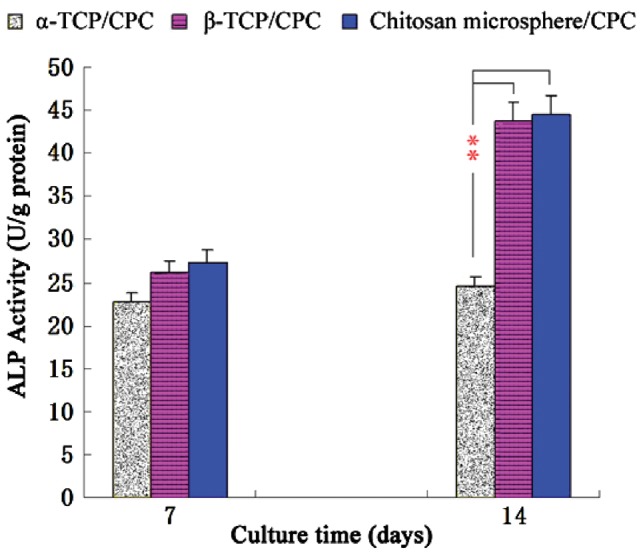
ALP Activity values of three types of material on different days (**P < 0.01)